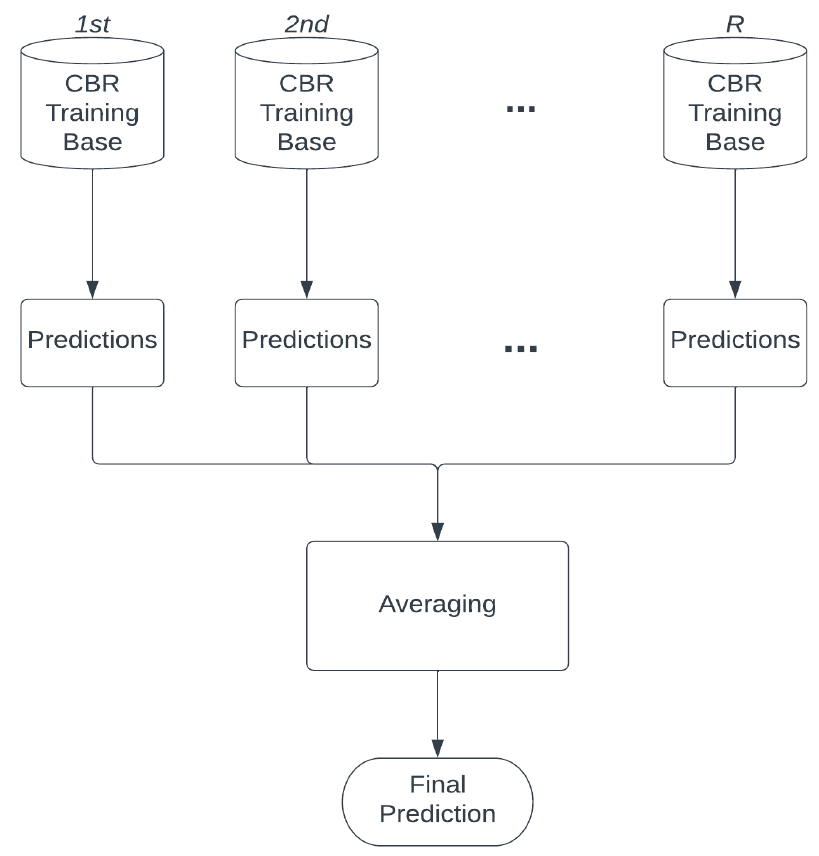
Figure 4. Bagging